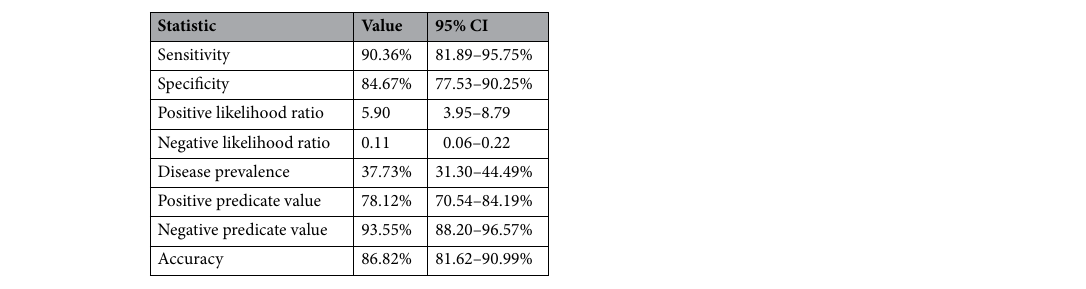
Table 5. Performance metrics of the validation phase.